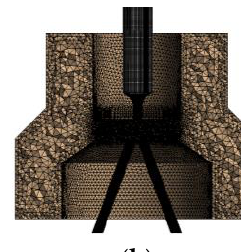
( b ) Figure 11. Streamline distribution diagram of jet tube migration. ( a ) Z projection; ( b ) X projection. The pressure distribution in the pre-stage flow field is shown in Figure 12. As can be seen from the figure, in the pipeline flow (as section I to section II in Figure 5), the oil pressure starts to decrease after the vena contracta and drops to 𝑃 𝑡 at the nozzle. In the impact jet region (as section II to section IV in Figure 5), the oil pressure increases at the position above the upper surface of the receiver due to the impingement zone. The nega- tive pressure area around the receiving hole is caused by the vortex dissipating part of the jet energy [23]. Therefore, compared with the left side, the negative pressure area on the right side has a lower pressure value and a larger area. When the oil enters the receiving channels, the pressure remains stable. During the flow from the nozzle to the receiving channels, the oil has completed two pressure changes, undergone the energy conversion from pressure energy to kinetic energy, and kinetic energy to pressure energy.